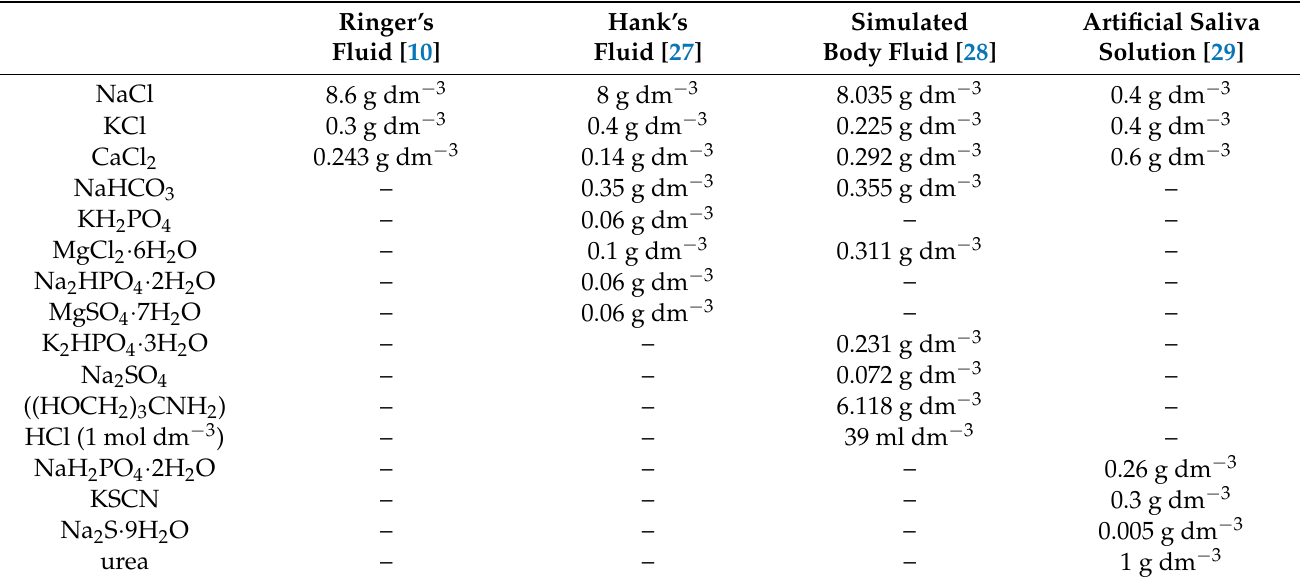
Table 1. Chemical composition of physiological